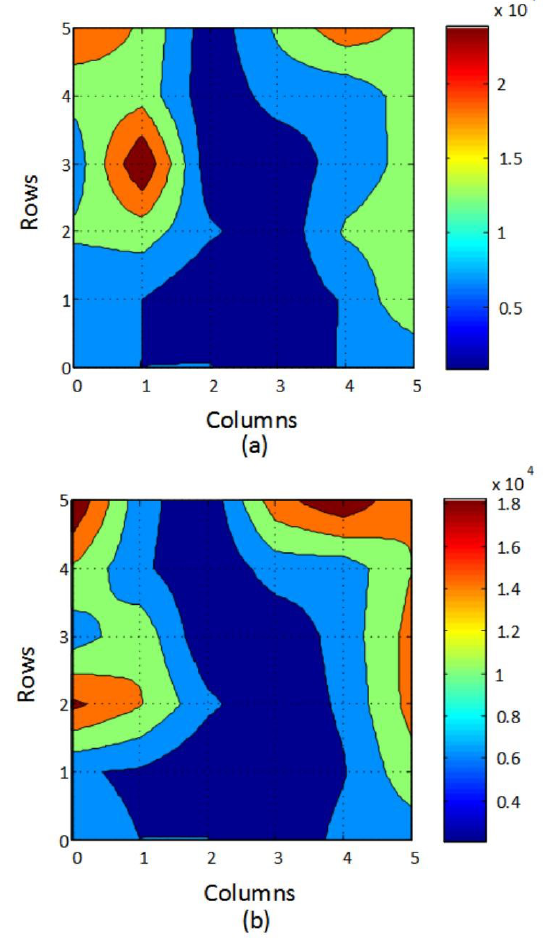
Fig. 11. Moisture stains mapping: (a) proposed method and (b) moisture meter TDR. In this same area and at the same time it was used a Time-Domain Reflectometer (TDR) to measure the soil moisture content in order to compare the results found in the proposed method.